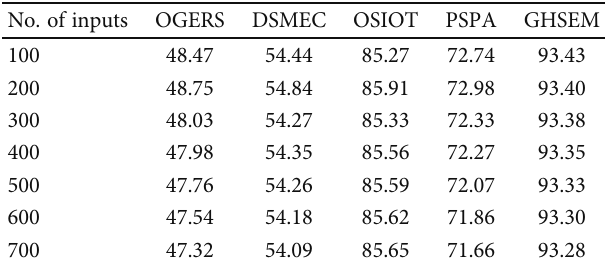
Table 4: Comparison of fault